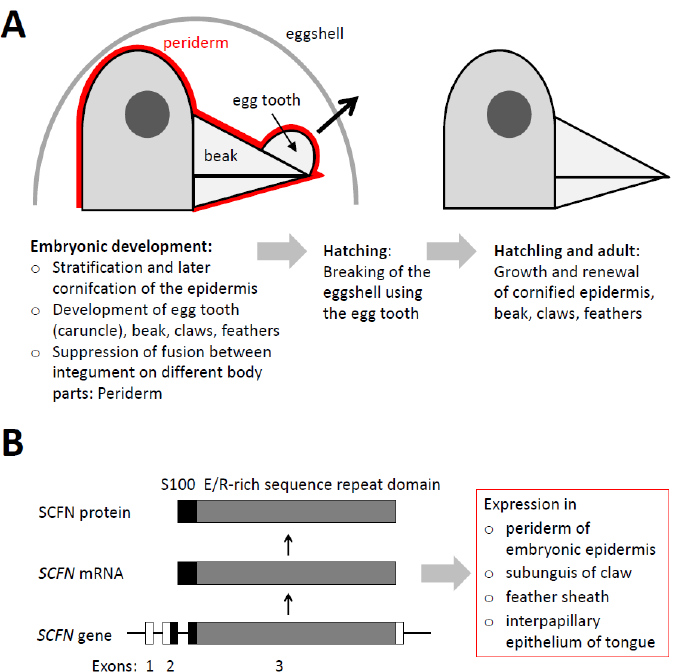
Figure 1. Schematic overview of beak development and SFTP gene expression. ( A ) Schematic depiction of the development and function of avian beak and egg tooth. ( B ) Organization and expression of the avian scaffoldin (SCFN)/trichohyalin-like gene, mRNA and protein. E, glutamic acid; R, arginine.